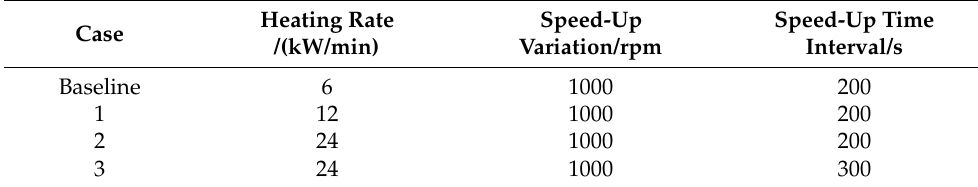
Table 11. Parameters of different cases in phase